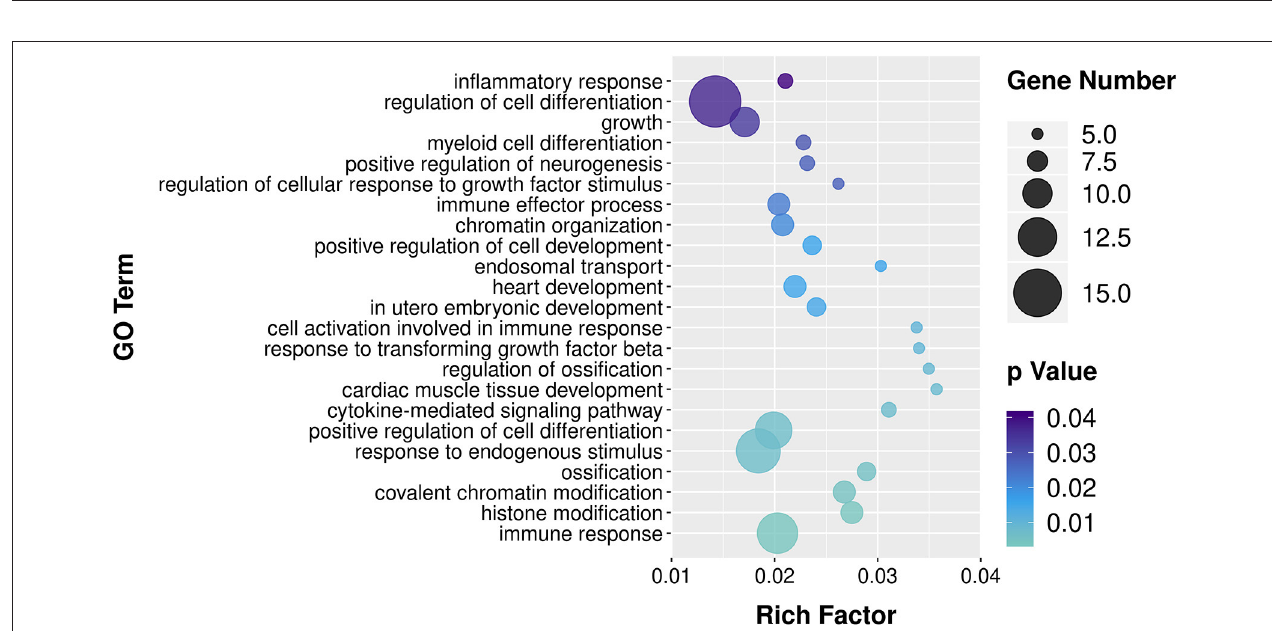
FIGURE 2 | Expression of five randomly selected circRNA (A) , miRNA (B) , and mRNA (C) molecules in the goat lung samples as determined by qPCR analysis. GAPDH was used as a reference for normalization of mRNA and circRNA expression, while 5S rRNA was used as a reference for normalization of miRNA expression. The different letters above the bars indicate significant differences among groups ( p < 0.05). Samples were collected from three goats per group (CK, uninfected control group; Pm, P. multocida -challenged group).